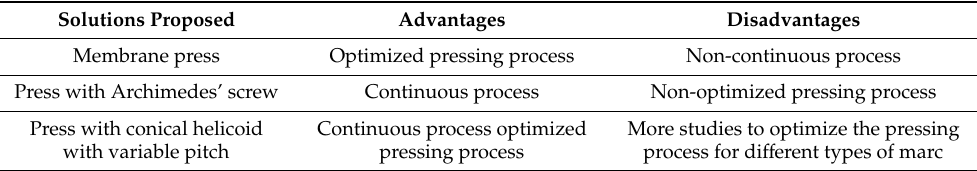
Table 1. Solutions proposed to perform grape pomace